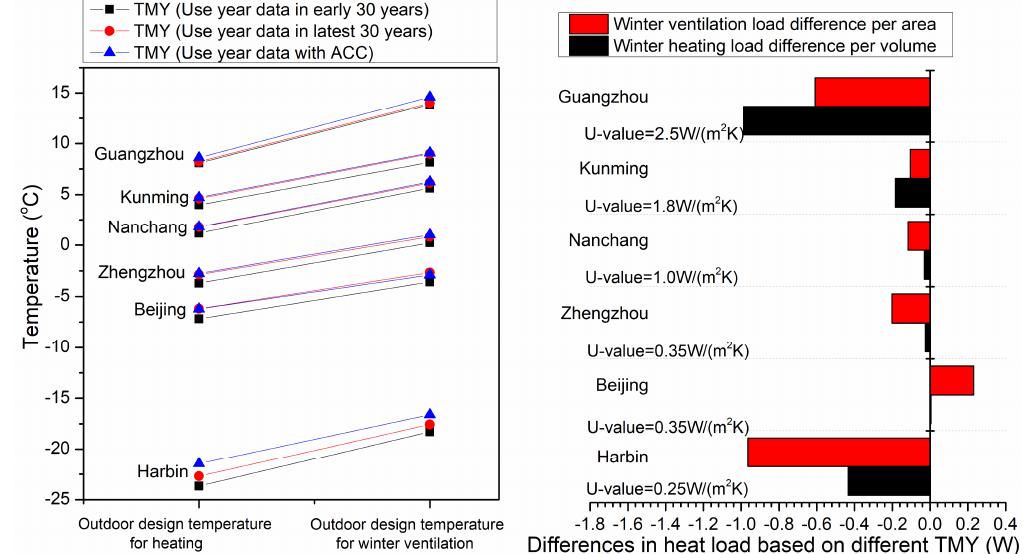
Figure 11. Influence of ACC on outdoor design